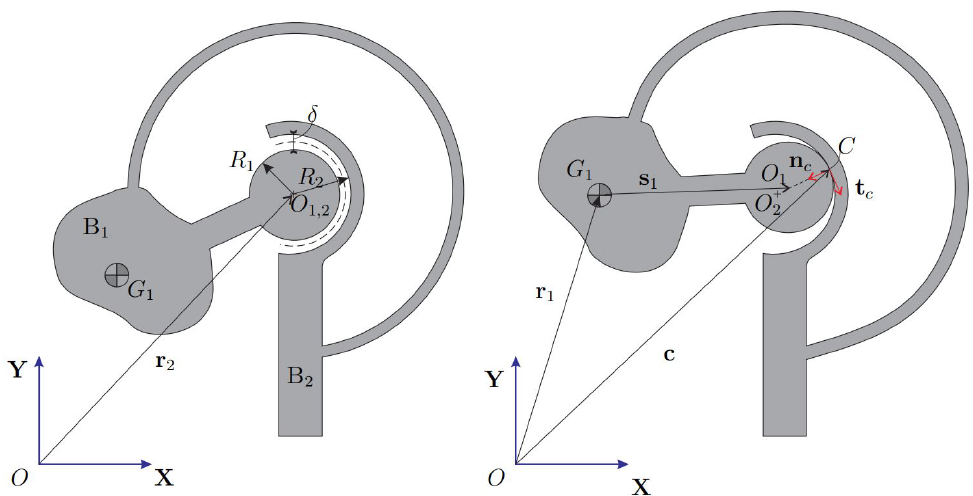
Figure 2. Undeformed CSFH ( left ). Deformed CSFH with impact ( right